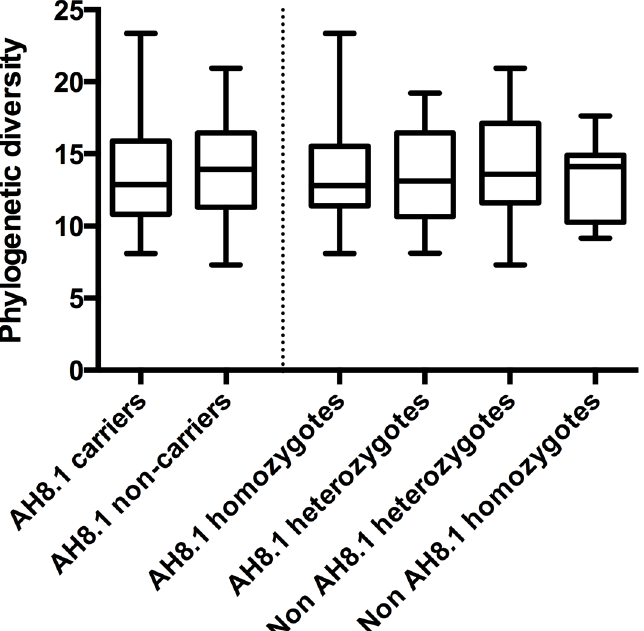
Fig 1. Phylogenetic diversity according to the ancestral HLA haplotype AH8.1 status. Phylogenetic diversity, an alpha diversity measure of bacterial richness, is shown according to carrier status of the AH8.1 haplotype (left), as well as the pre-defined HLA genotype groups (right, AH8.1 homozygotes, i.e. homozygosity for both HLA-B * 08 and HLA-DRB1 * 03; AH8.1 heterozygotes, i.e. at least 1 copy of HLA-B * 08 and HLA-DRB1 * 03; Non AH8.1 heterozygotes, i.e. HLA-B * 08 and HLA-DRB1 * 03 both not present. Non AH8.1 homozygotes, i.e. HLA-DRB1 homozygous but non AH8.1). There were no significant differences between the